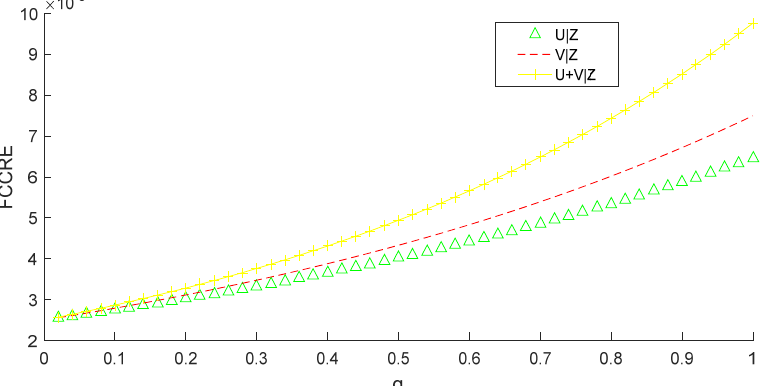
Figure 7. Fractional conditional cumulative residual entropy ε q ( U | Z ) , ε q ( V | Z ) , and ε q ( U + V | Z )